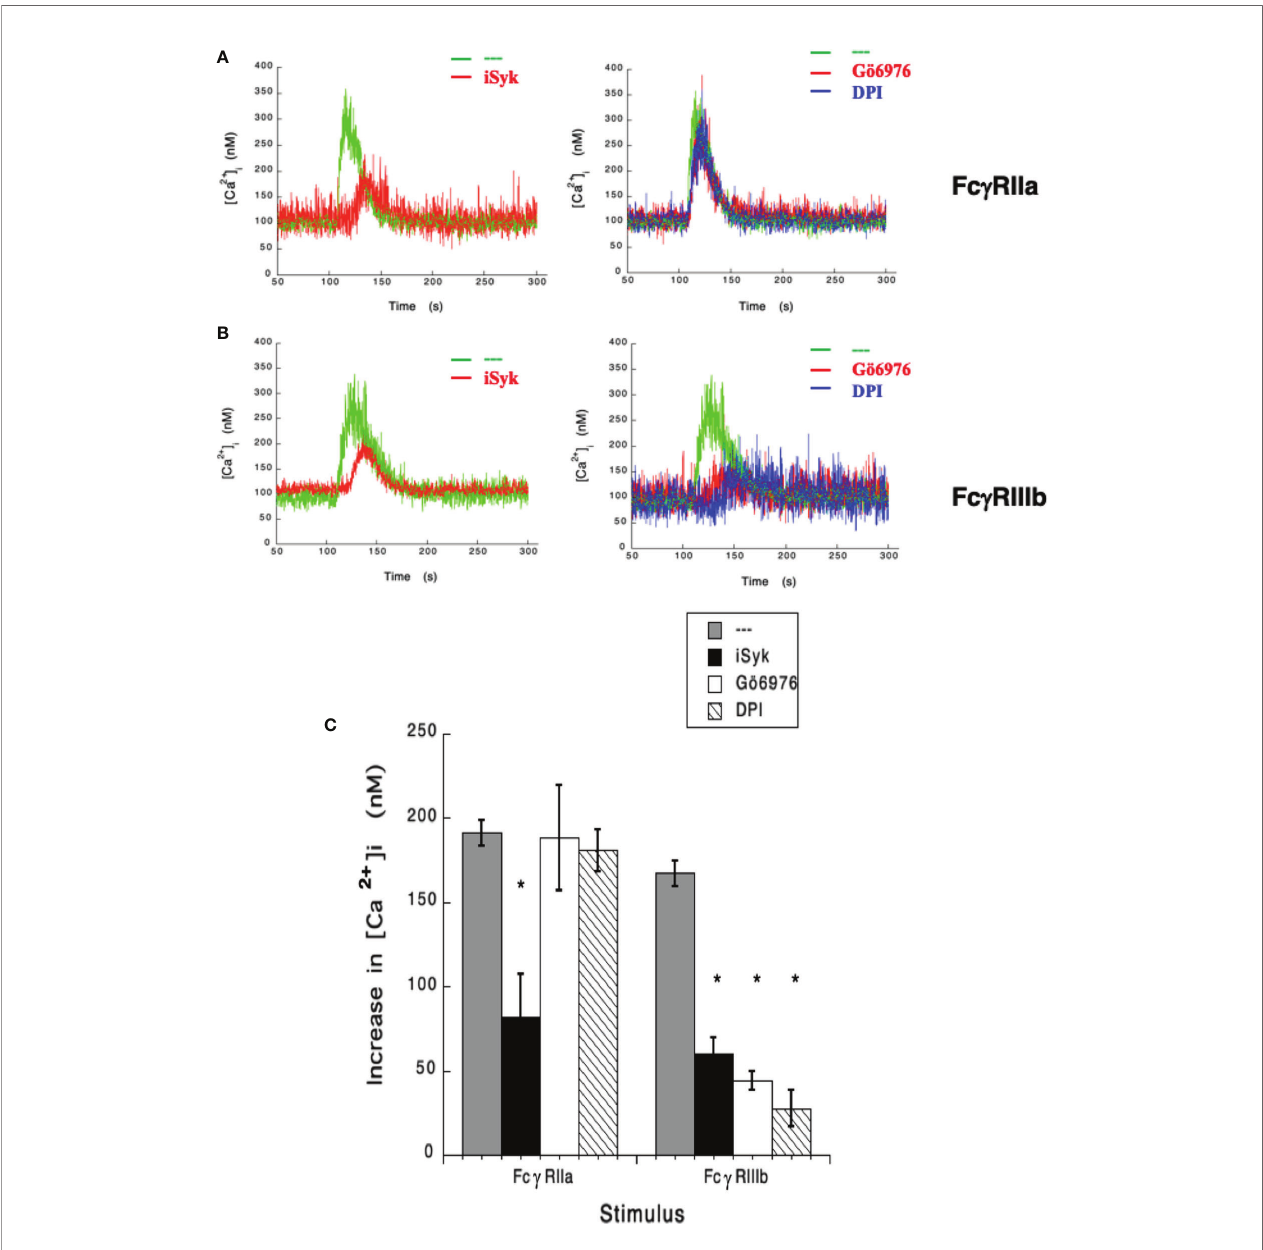
FIGURE 3 | Fc g RIIIb-mediated increase in [Ca 2+ ] i . depends on Syk, PKC and NADPH-oxidase. Fura-2-loaded human neutrophils in PBS with Ca 2+ and Mg 2+ were left untreated (green line), or treated with 1 µM iSyk, a Syk inhibitor; 1 µM Gö6976, a PKC inhibitor; 10 µM DPI, a NADPH-oxidase inhibitor, before being stimulated by aggregating Fc g RIIa (A) or Fc g RIIIb (B) . Arrow indicates the moment when the stimulus was added. Changes in cytosolic calcium concentration ([Ca 2+ ] i ) were assessed by measuring the variations in fl uorescence as described in material and methods. Tracings are representative of three experiments with similar results. (C) Increments in [Ca 2+ ] i were calculated by subtracting the baseline value from the maximum value after stimulation. Data are mean ± SEM of three independent experiments. Asterisks (*) denote conditions that were statistically different from untreated cells (p <